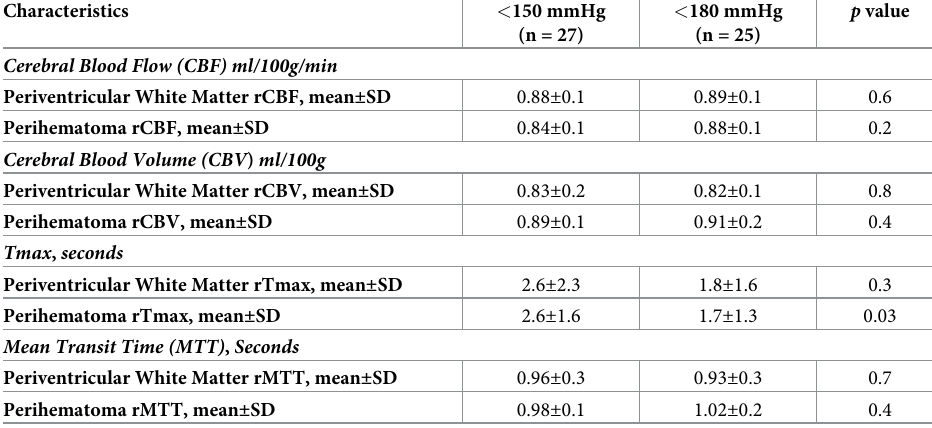
< 180 mmHg p value (n = 27) (n = 25)